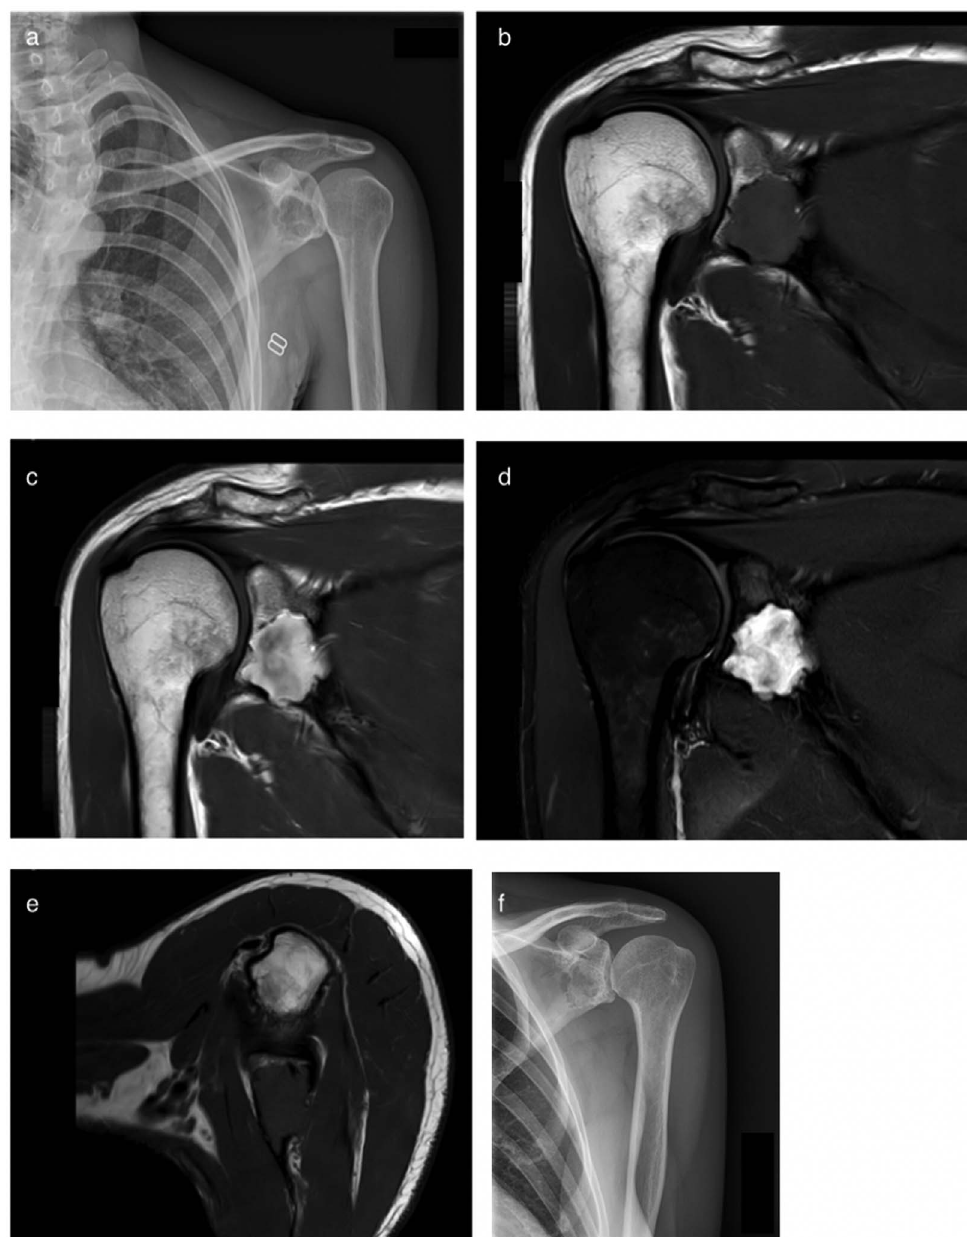
Figure 1. (a) X-ray shows osteolytic lesion in the glenoid with sclerotic border and trabeculation. (b and c) Frontal images in T1WI show an intraosseous lesion with clear cortical breach inferiorly and discrete soft tissue expansion outside the glenoid. There is contrast enhancement after administration of gadolinium. (d) There is hyperintense signal in T2WI. (e) Axial images also show an isointense signal to muscle tissue and cortical breach laterally. (f) No recurrence is seen on X-ray after 12